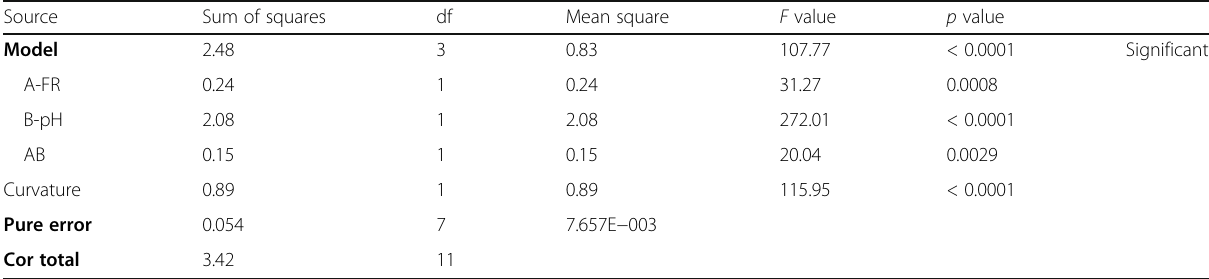
Table 1 ANOVA table for retention